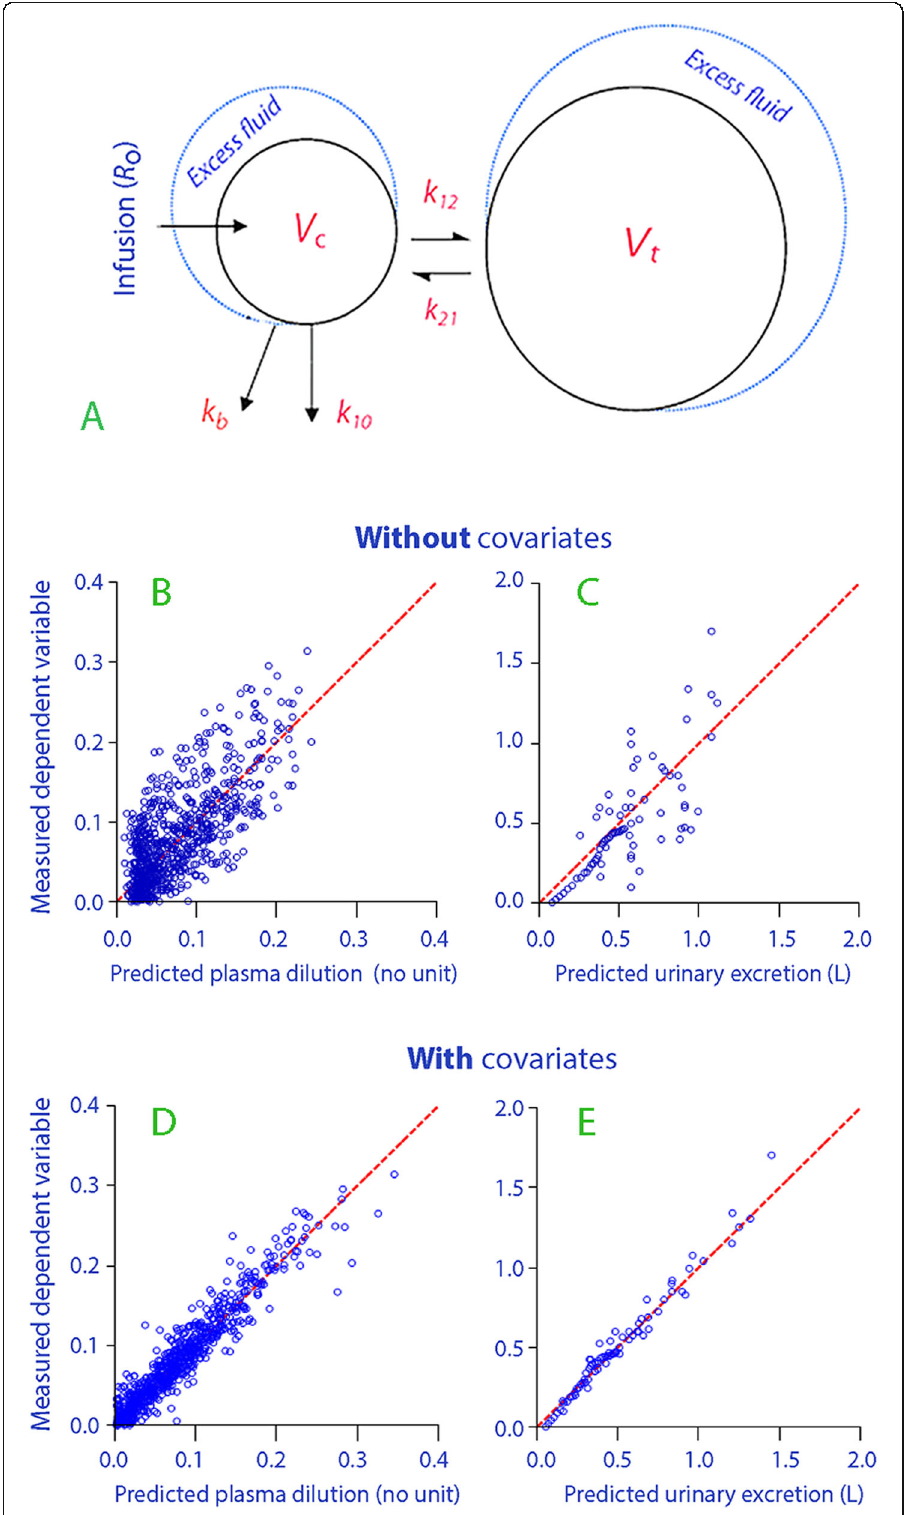
Fig. 2 Schematic drawing of the kinetic model (a). Measured versus model-predicted plasma dilution and urinary excretion without ( b , c ) and with ( d , e ) consideration of the covariates of infusion rate and body